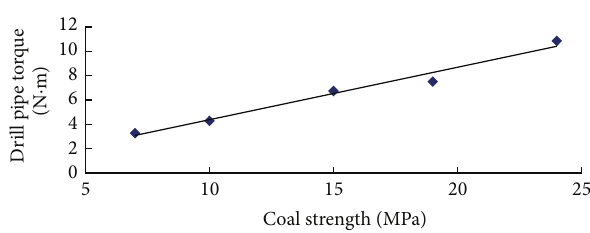
Figure 7: The curve relation between drill pipe torque and coal strength.